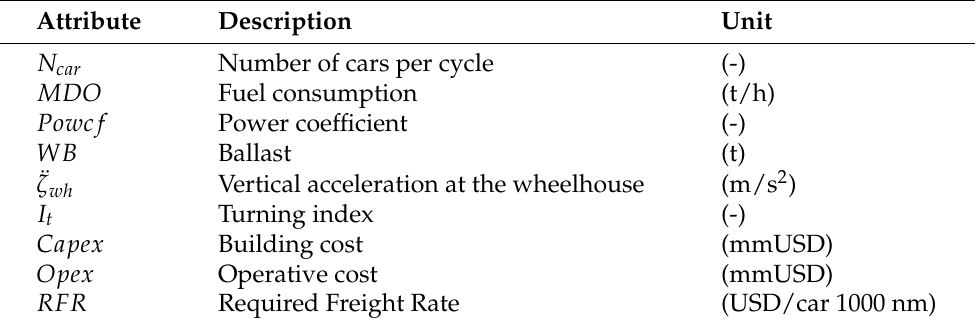
Table 2. Primary attributes in the design